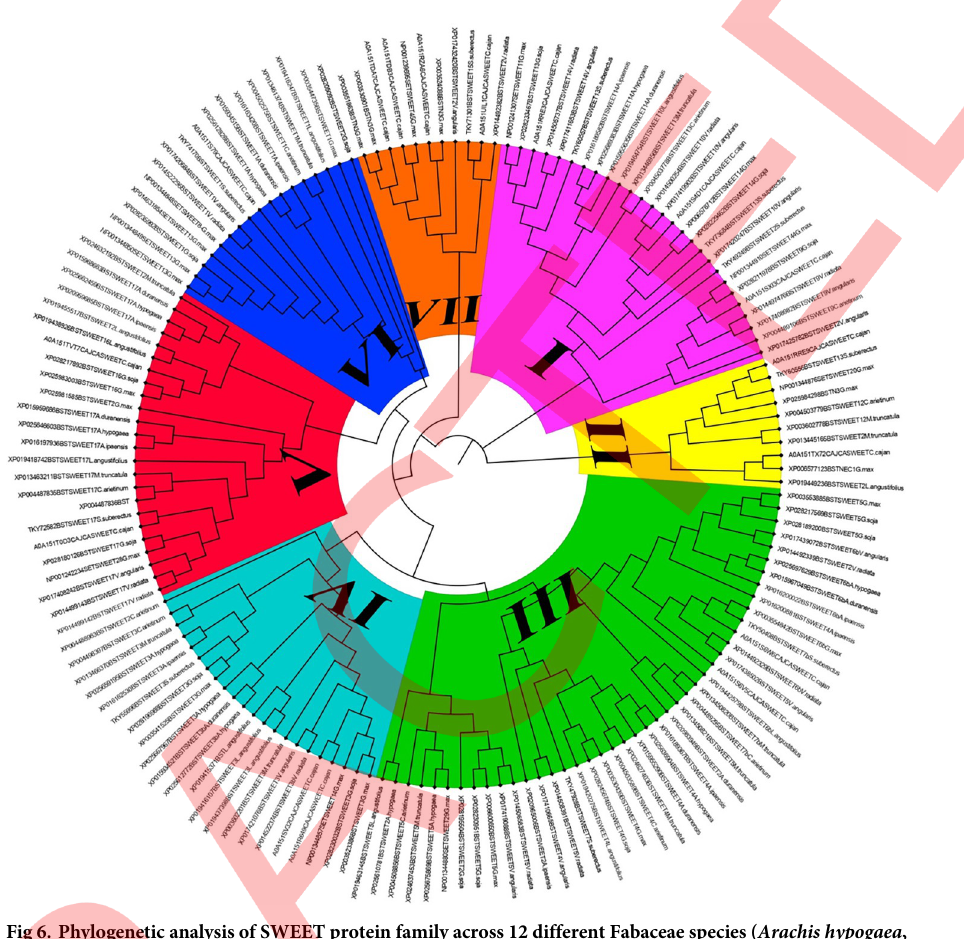
Fig 6. Phylogenetic analysis of SWEET protein family across 12 different Fabaceae species ( Arachis hypogaea , Cajanus cajan , Cicer arietinum , Cicer pinnatifidum , Glycine max , Glycine soja , Medicago sativa , Medicago truncatula , Pisum sativum , Vigna mung , Vigna radiate , and Vigna unguiculata ). A putative function of the SWEET protein can be predicted using amino acid-based phylogenetic